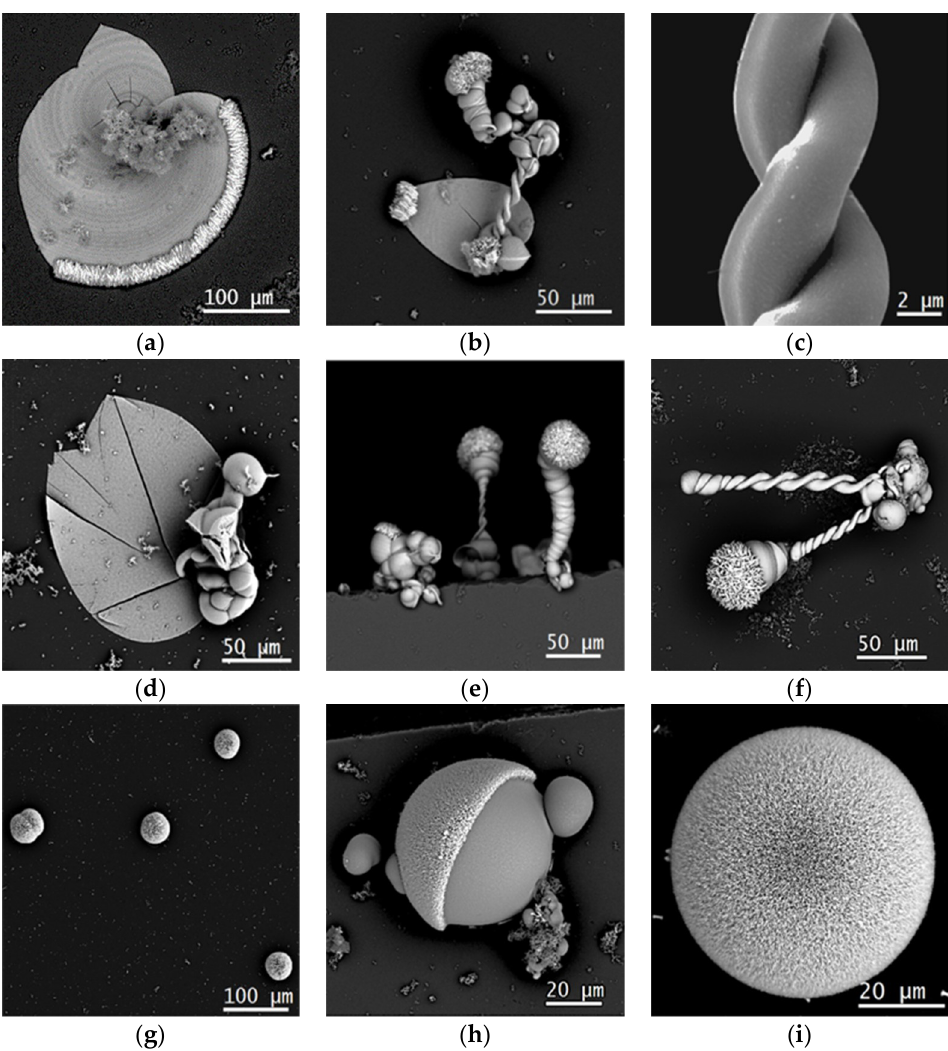
Figure 2. Scanning electron microscopy images of Ba silica-carbonates. ( a–c ) Control structures with no PA; ( d–f ) Structures synthetized with [0.01 M] PA; ( g–i ) Structures synthetized with [0.1 M] PA where spherical and semispherical morphologies were found.